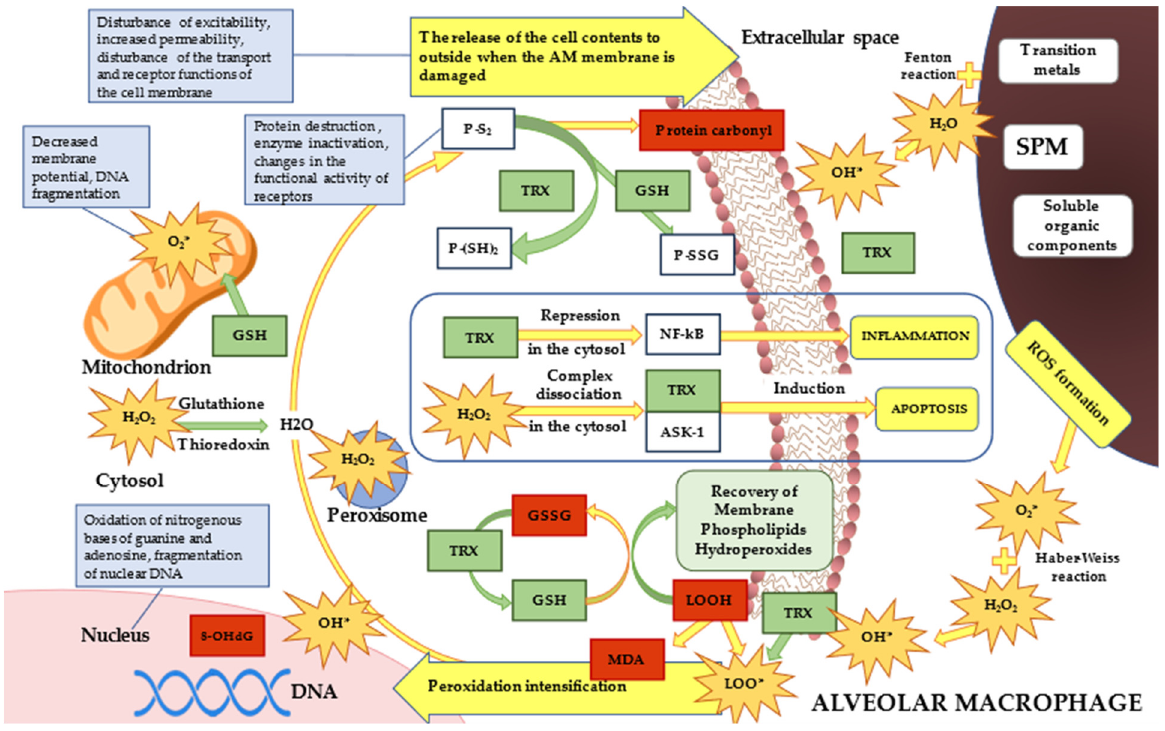
Figure 8. Pathophysiological mechanisms of redox processes violation in AM of Wistar rats when exposed to SPM. Note: LOOH—lipid hydroperoxides, MDA—malonic dialdehyde, DNA—deoxyri-